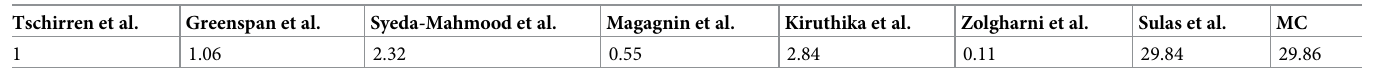
Table 7. Processing time (seconds) for the five fetal heartbeats in Fig 2, for the state-of-the-art chains in Table 1. Tschirren et